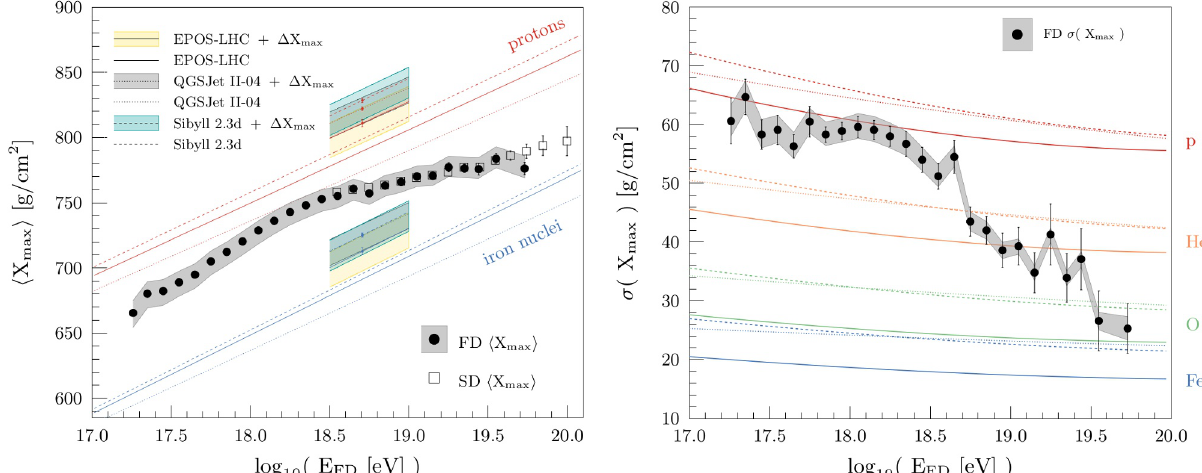
Figure 9: The energy evolution of the mean X max (left) and the standard deviation of X max (right) measured by the Pierre Auger Observatory (in black) using FD [9] and SD [17]. The adjusted X max scales of MC predictions (left panel) obtained using the fit results in the energy range 10 18 . 5 − 10 19 . 0 eV are shown in blue and red for protons and iron nuclei, respectively, with the bands corresponding to the systematic uncertainties. The original predictions by hadronic interaction models are depicted by lines without